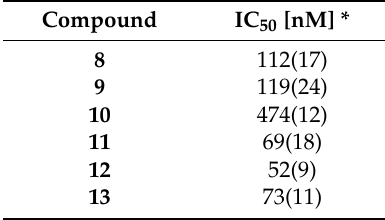
Table 1. Enzyme assay test results of compounds 8 – 13 .